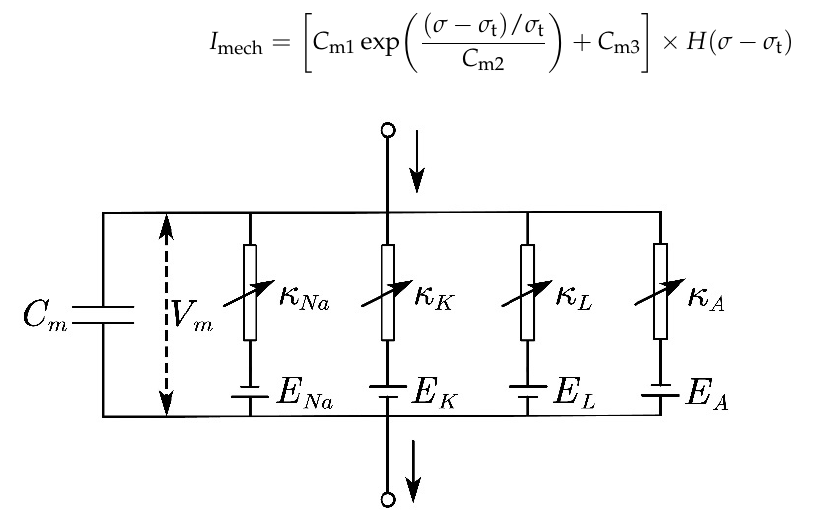
where V m (mV) stands for the membrane potential of the nociceptors, and t (ms) represents the time. C m = 1 µ F/cm 2 is the membrane capacitance per unit area [9]. I Na , I K , I A , and I L correspond to the current induced by the sodium ions (Na + ), potassium ions (K + ), fast transient K + , and leakage current component. I mech is the current induced by the mechanical stimuli, which is revealed to be a function of the stress at the location of the nociceptor: